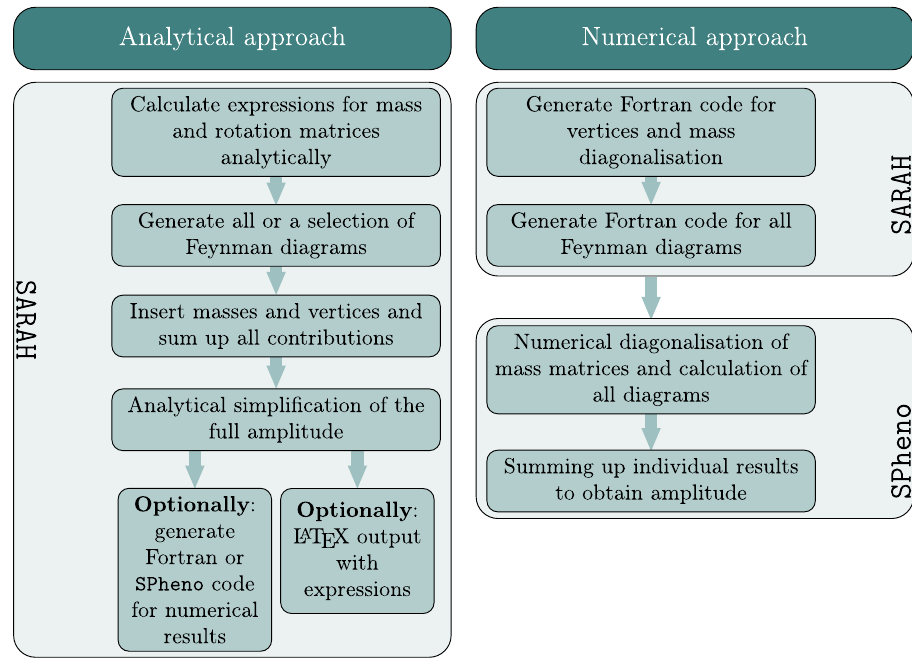
Fig. 4 Schematic procedure for the two options to calculate matching conditions with SARAH /